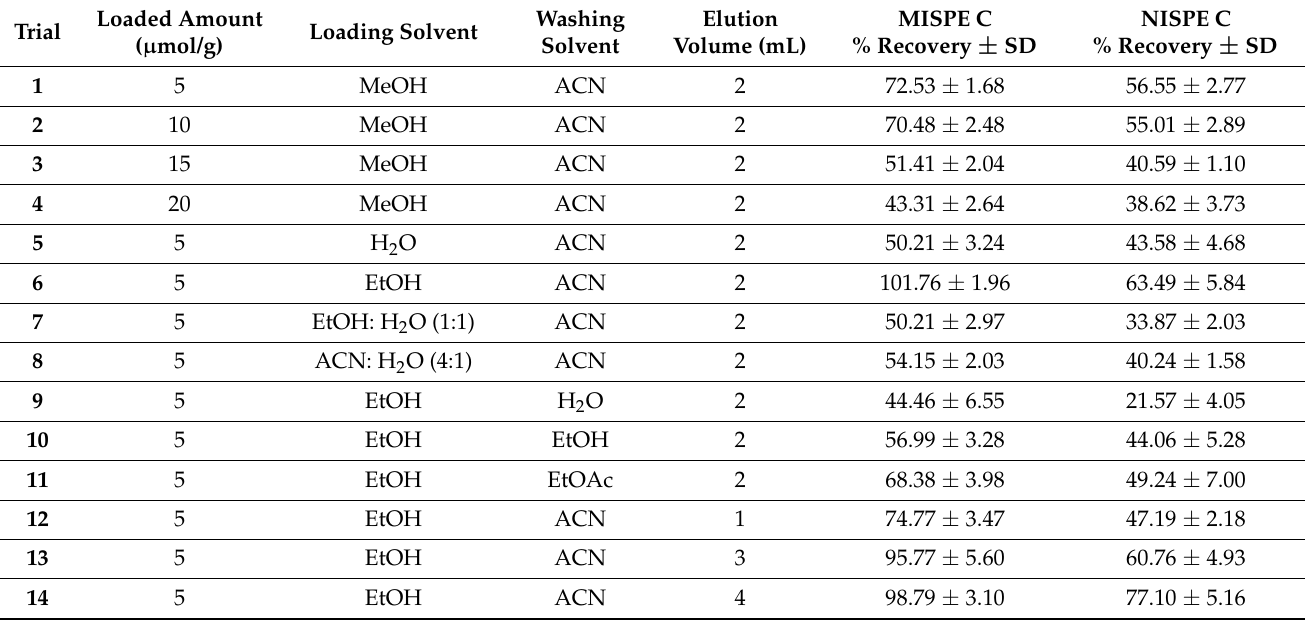
Table 4. Percent recoveries of QA during SPE